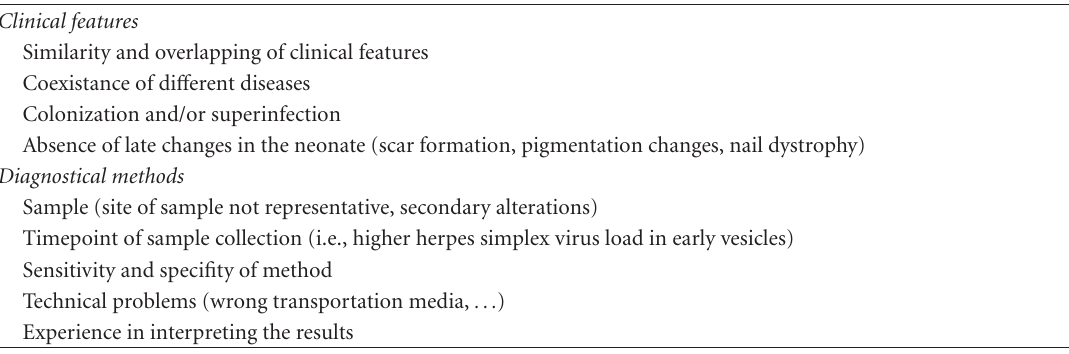
Table 2: Variables causing problems in di ff erential